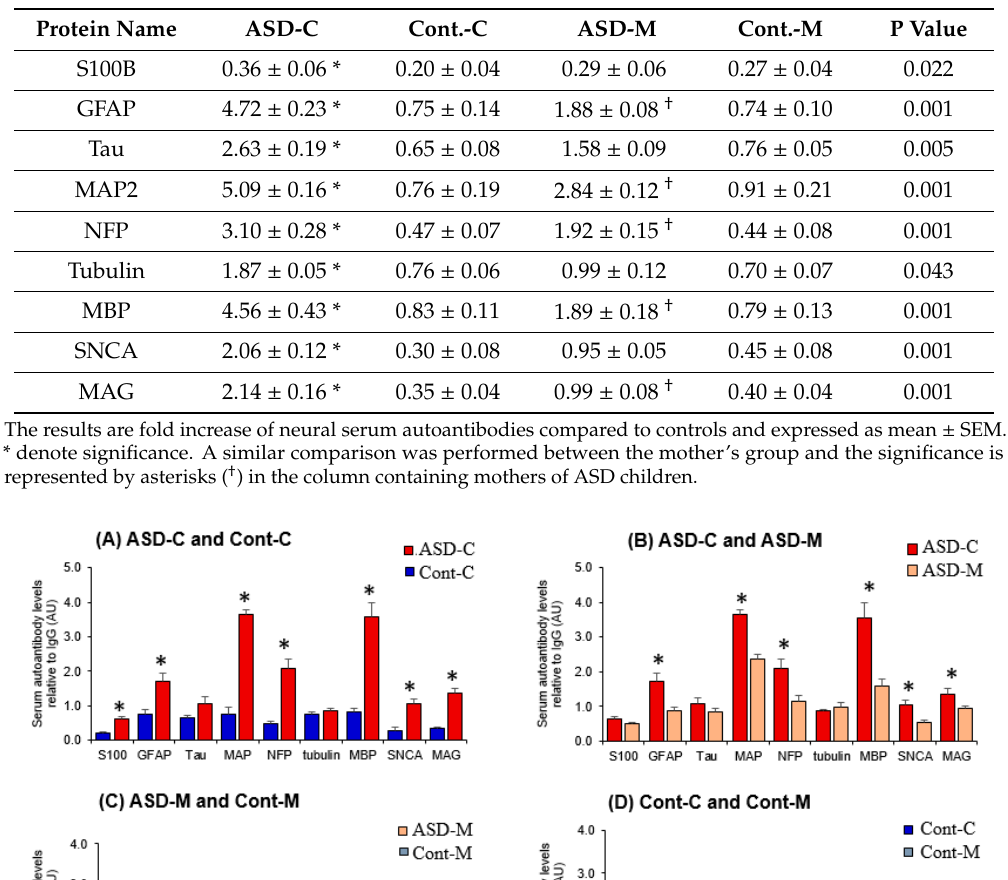
Table 3. Autoantibodies against neuronal proteins in the sera of children with autism (ASD-C), healthy children (Cont-C), mothers of ASD children (ASD-M) and mothers of healthy children (Cont-M).